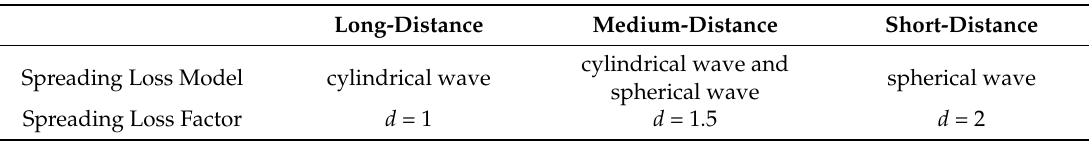
Table 3. Spreading loss model for different communications